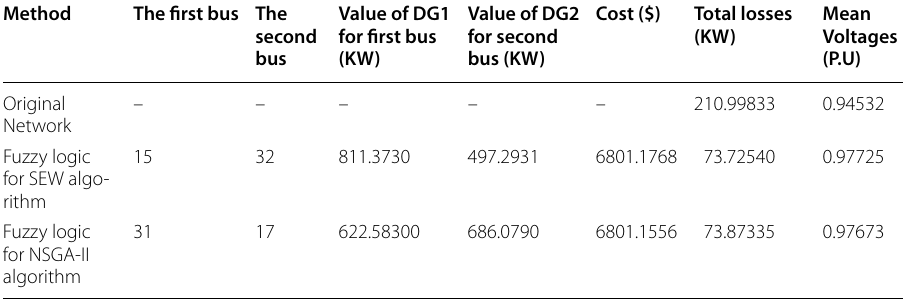
Table 7 Comparison of the results of NSGA-II and SEW algorithms for decision-making by fuzzy logic method